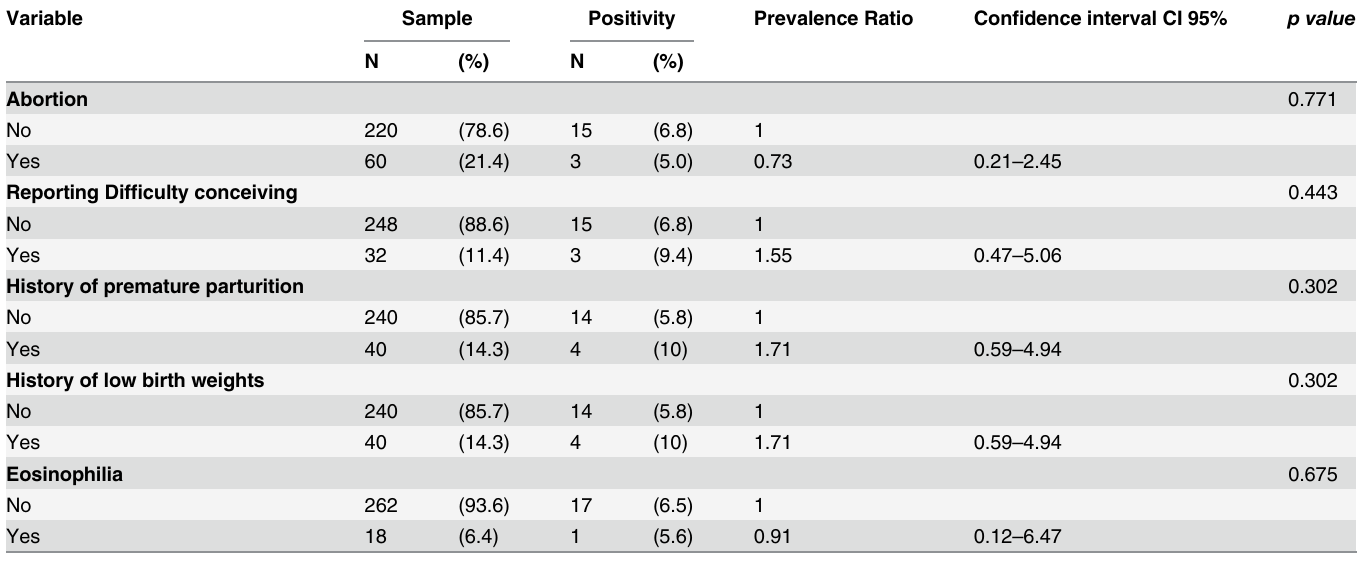
Table 3. The seropositivity (IgG) for Toxocara spp. according to the obstetric history and the blood eosinophilia status in the pregnant women attended at the University Hospital of Rio Grande — RS, from May 2011 to April 2012 (n =